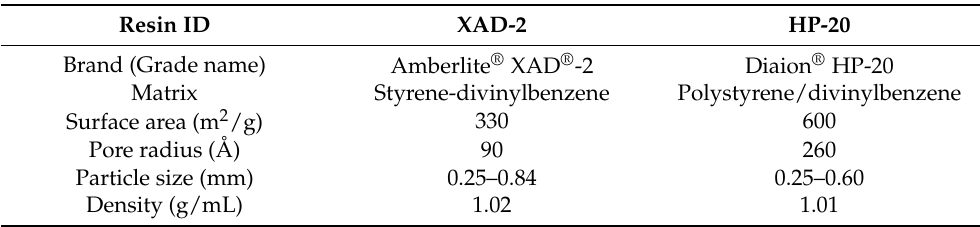
Physicochemical characteristics of the commercial resins used for the recovery of phenolic